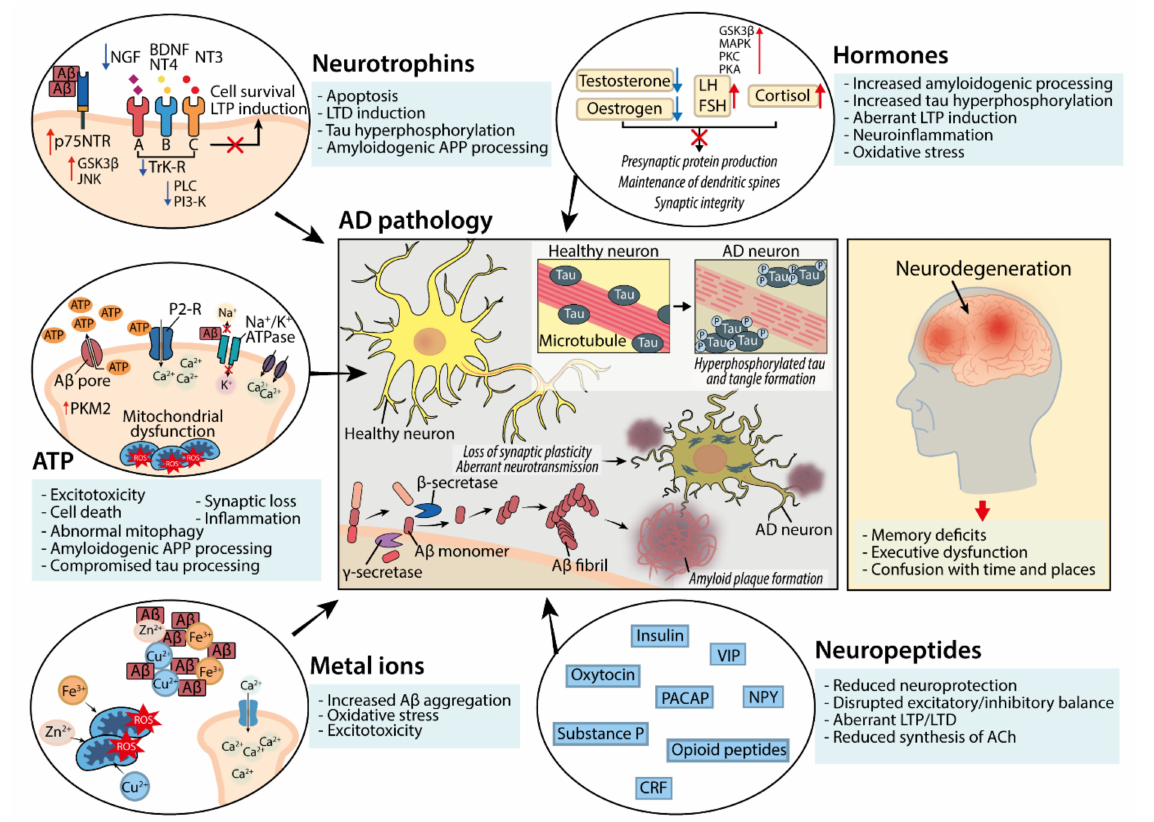
Figure 1. Summary of neuromodulator dysfunction in Alzheimer’s disease. Alterations to neuro- modulator function are being increasingly regarded as critical drivers of AD pathology and resulting neurodegeneration and cognitive deficits. Alterations to levels of neuropeptides bring about com- promised neuroprotection, reduced synthesis of neurotransmitters such as acetylcholine,